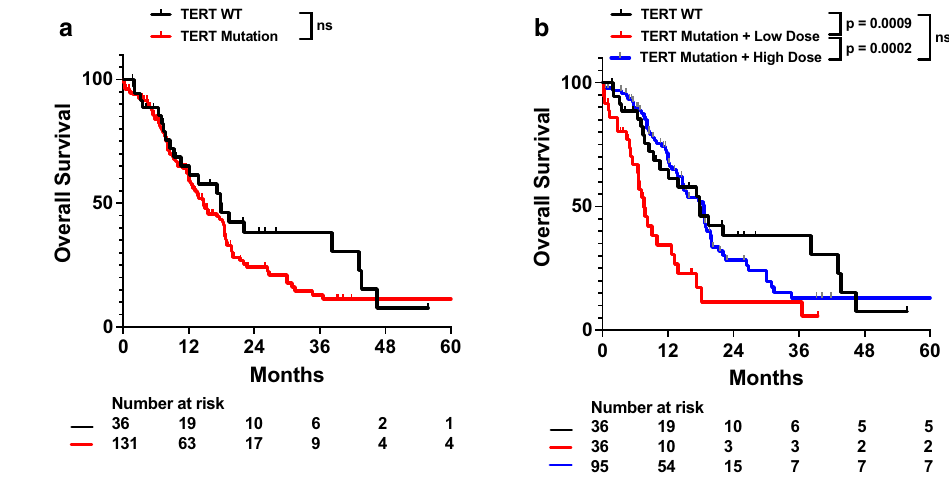
Fig. 4 Univariate impact of TERT mutations on OS in full patient cohort. Kaplan– Meyer plots of OS comparing patients with ( a ) different TERT mutation status and ( b ) TERT wild type status vs TERT mutant status with